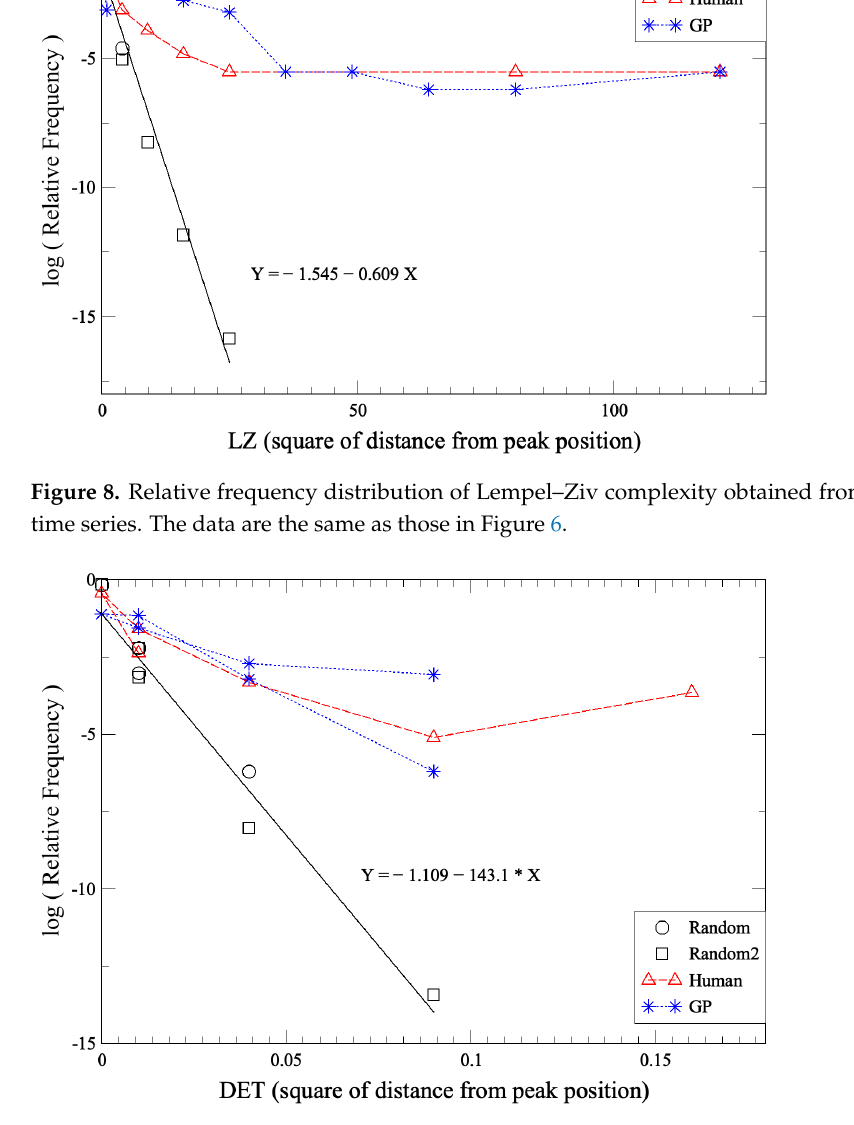
Figure 9. Relative frequency distribution of DET from recurrence plot obtained from the set of RPS time series. The data are the same as those in Figure